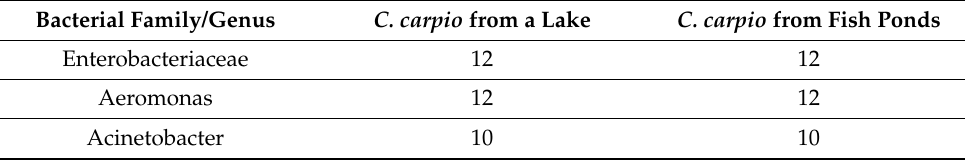
Table 1. The number of bacterial isolates for antimicrobial resistance testing. Bacterial